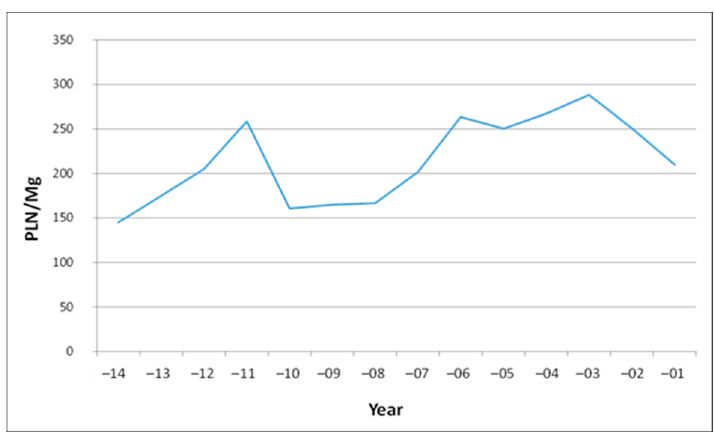
Figure 4. Methanol prices (nominal values) (source: [42]).